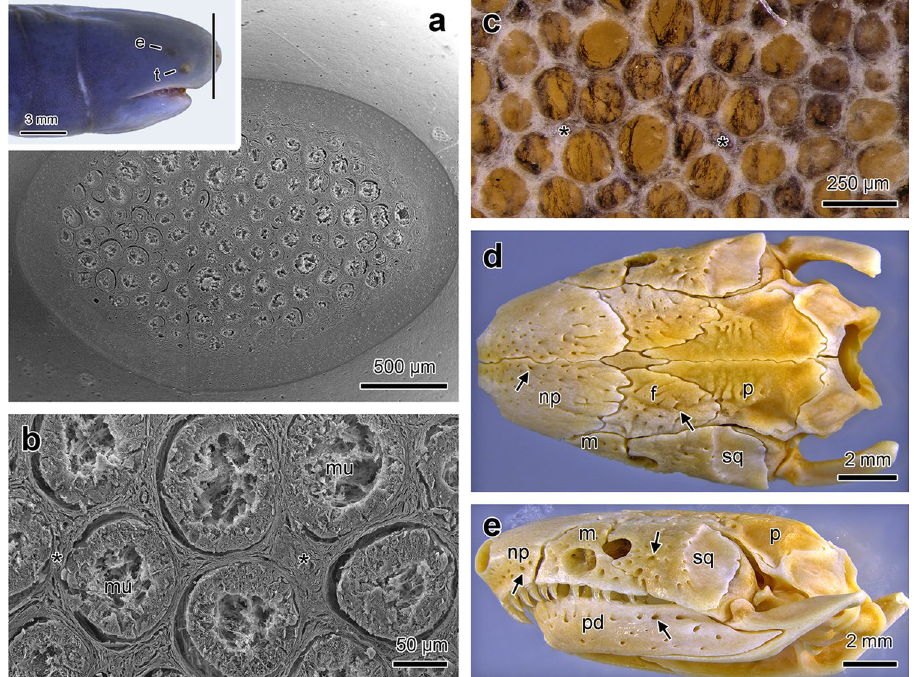
Figure 1. Internal morphology of the head skin and anatomy of the skull of Siphonops annulatus . ( a ) Internal aspect of the dermis of the snout tip revealed in transversal section, as exemplified in the insert. Note the large number of skin glands arranged side by side. ( b ) Higher magnification of (A) revealing the predominance of mucous glands (mu), which are identified by the presence of lumens. Note the collagen walls among the glands ( * ), conferring to the dermis a honeycomb appearance. ( c ) Image of a corresponding region of ( b ) after removal of the mucous glands, leaving only the collagen. ( d – e ) The skull of S. annulatus show many tiny orificies (arrows) mainly in the nasopremaxilla (np), maxillopalatine (m), frontal (f), squamosal (sq), parietal (p) and pseudodentary bones (pd). Eye (e), tentacle (t). Scanning electron microscopy ( a and b ), stereomicroscopy (a insert, c – e